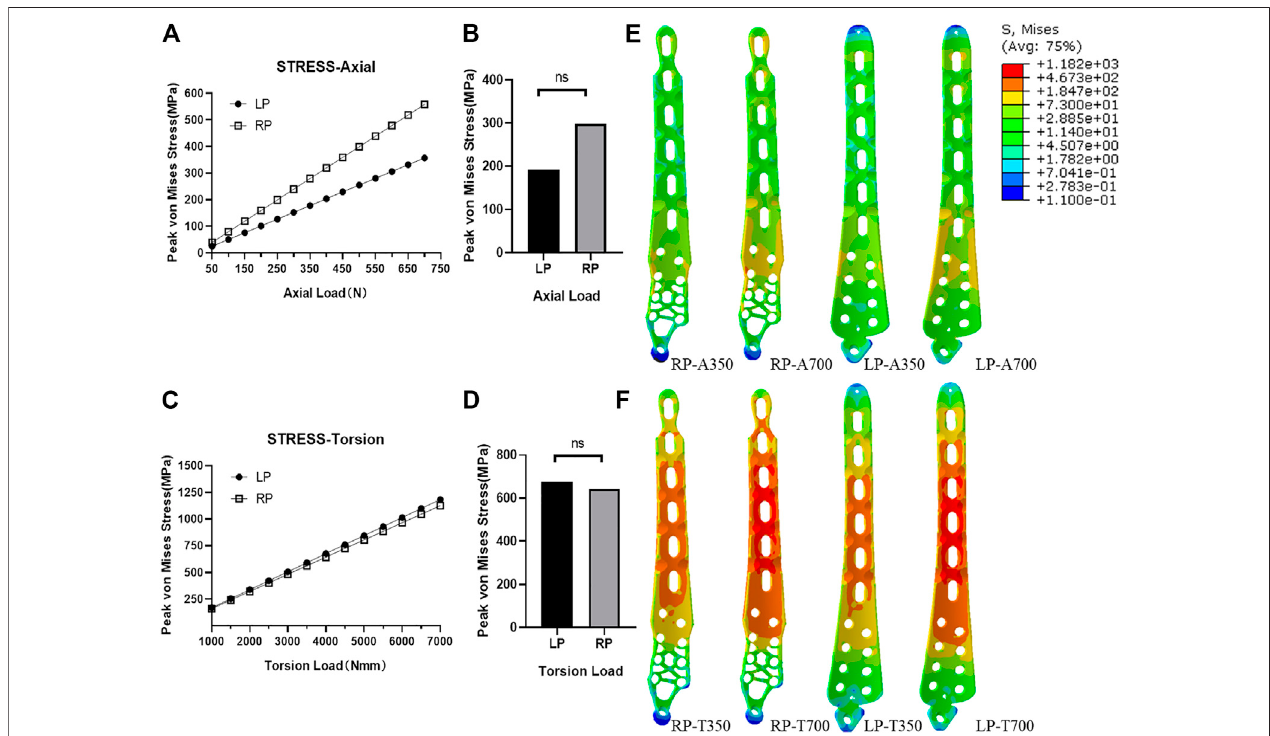
FIGURE 5 | Plate stress analyses. (A) Peak stress with difference load values for two kinds of plates under axial compression conditions. (B) Statistical analyses of peak stressoftheloadvalues ofLP and RPplate under axialcompression conditions ( p > 0.05). (C) Peakstresswithdifference loadvalues fortwokindsofplates under torsion conditions. (D) Statistical analyses of peak stress of the load values of LP and RP plate under torsion conditions ( p > 0.05). (E) Stress distribution of LP and RP plate under axial compression load conditions with a standard physiological load and twice that in the physiological load case. (F) Stress distribution of LP and RP plate under torsional conditions with a standard physiological load and twice that in the physiological load